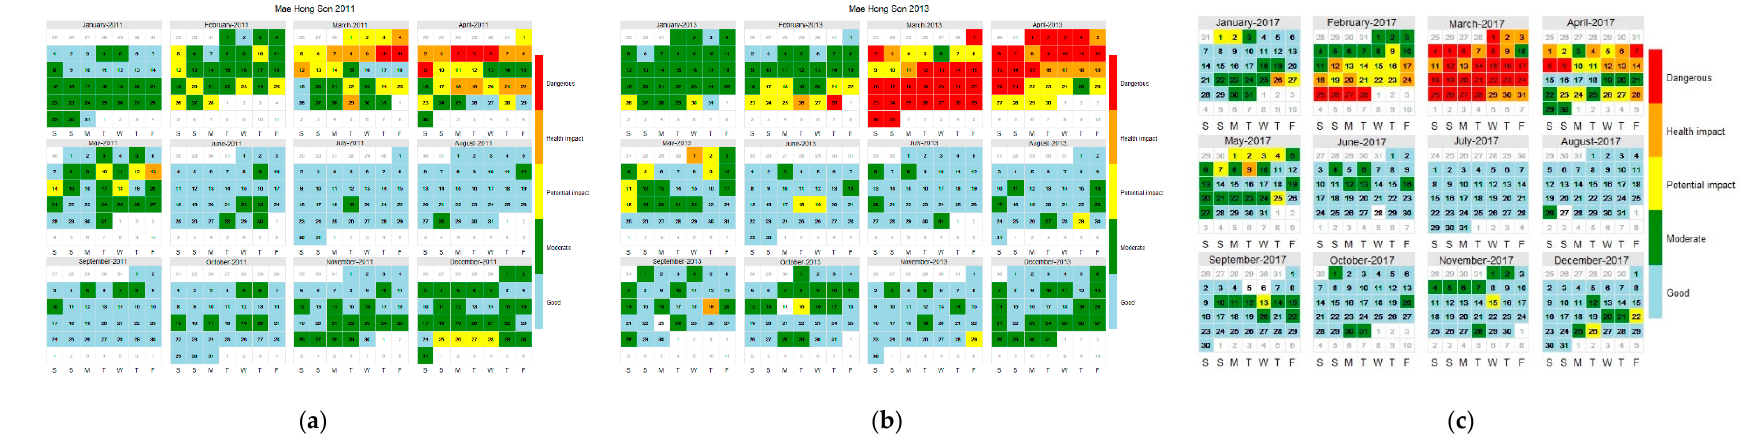
Figure 5. Calendar presentations of daily PM 10 concentrations in Mae Hong Son Province for 2011 ( a ), 2013 ( b ), and 2017 ( c ).